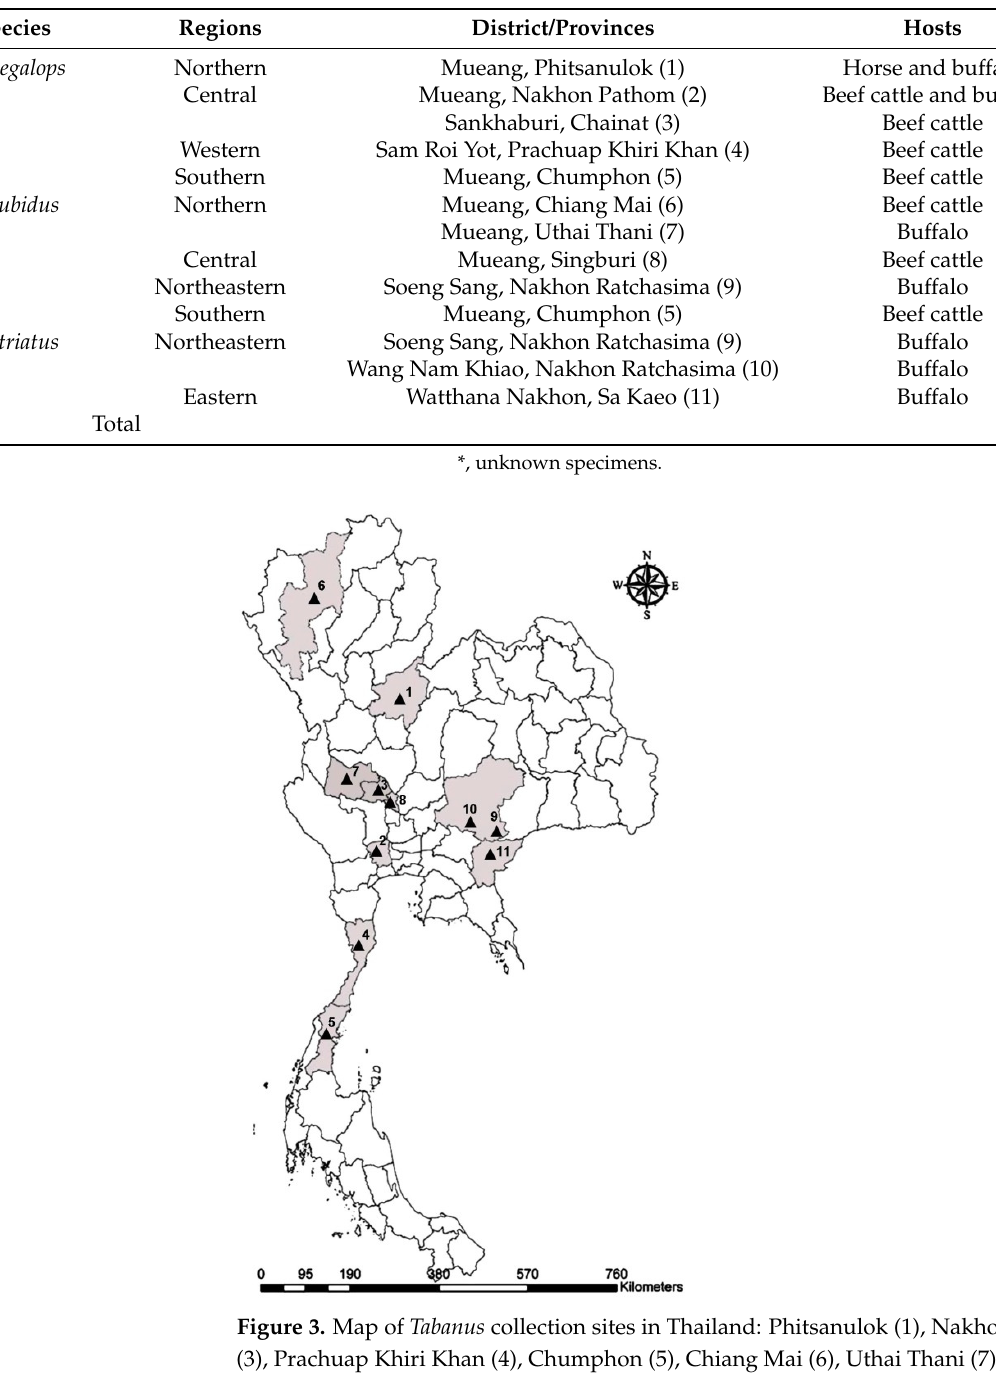
Table 1. Collection sites and number (N) of wing images of Tabanus spp. used for the landmark-based geometric morpho- metric analysis. Figures into brackets refer to sites in Figure 3.